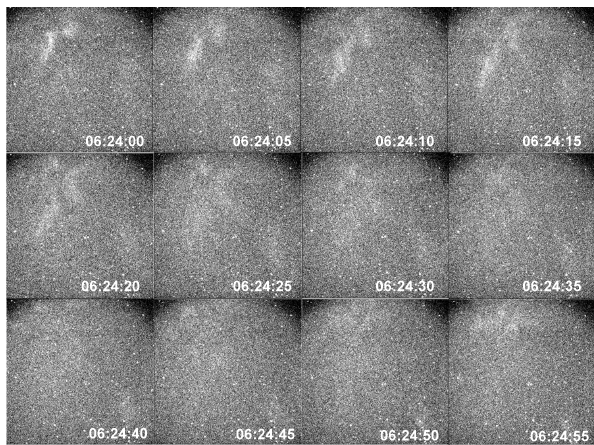
Fig. 3. 557.7nm emissions in the magnetic zenith imaged at 5s intervals during the first minute of a 2min transmitter pulse on 25 March 2006. Each frame is approximately 9 ◦ across. Time stamps refer to the start time for each 5s